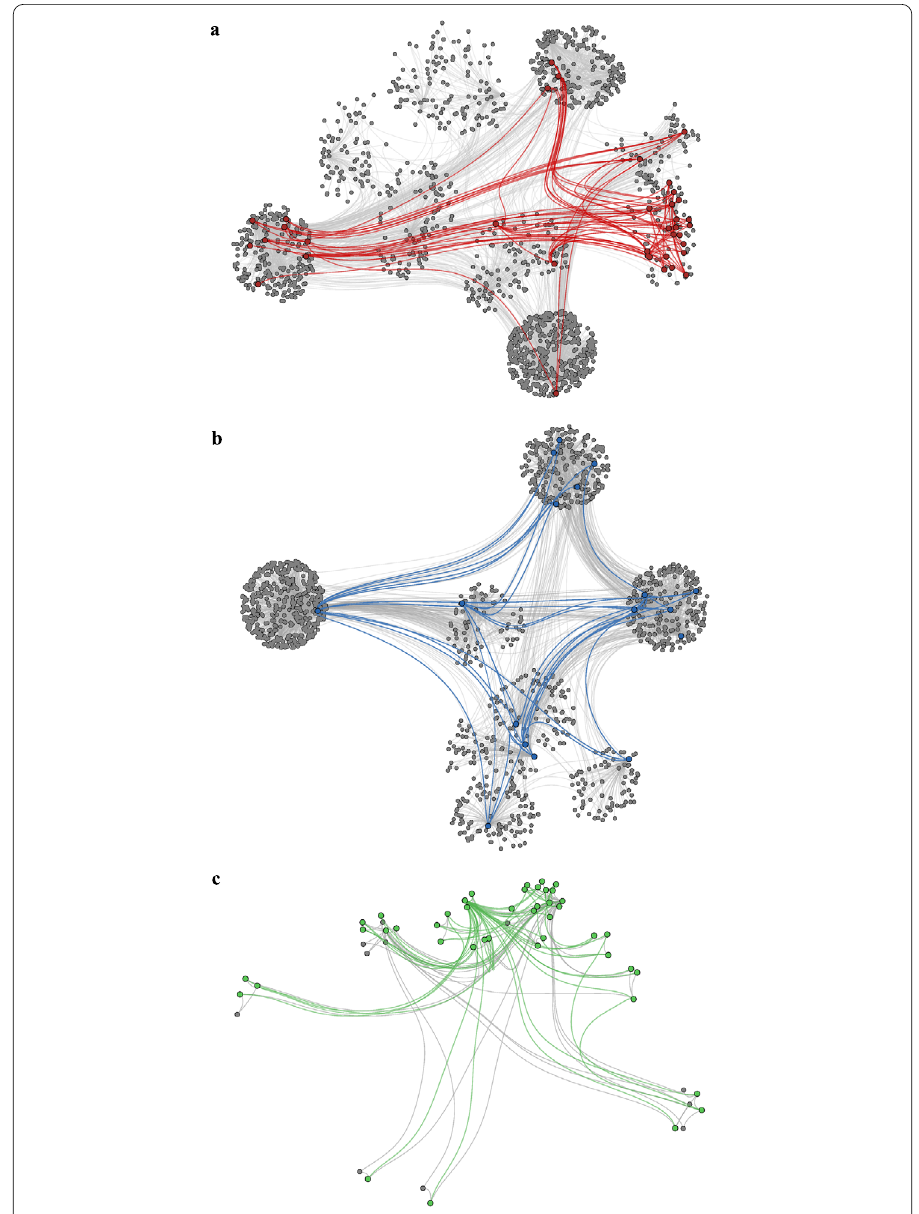
Figure 4 Reduced k -Cliques Embedded in the Unreduced Networks. ( a ) Simultaneous view of all reduced 5-cliques as they appear embedded into the original Panama Papers network after restoring their deleted 2-degree nodes and corresponding edges, thus they are not true cliques anymore but carry many connecting cycles. ( b ) Simultaneous view of all reduced 6-cliques as they appear embedded into the original Panama Papers network after restoring their deleted 2-degree nodes and corresponding edges. Although they are not true cliques in the unreduced network, they carry many connecting cycles. ( c ) Simultaneous view of all reduced 4-cliques as they appear embedded into the original Bahamas Leaks network after restoring their deleted 2-degree nodes and corresponding edges, in the original network they correspond to nodes that belong to many connecting cycles